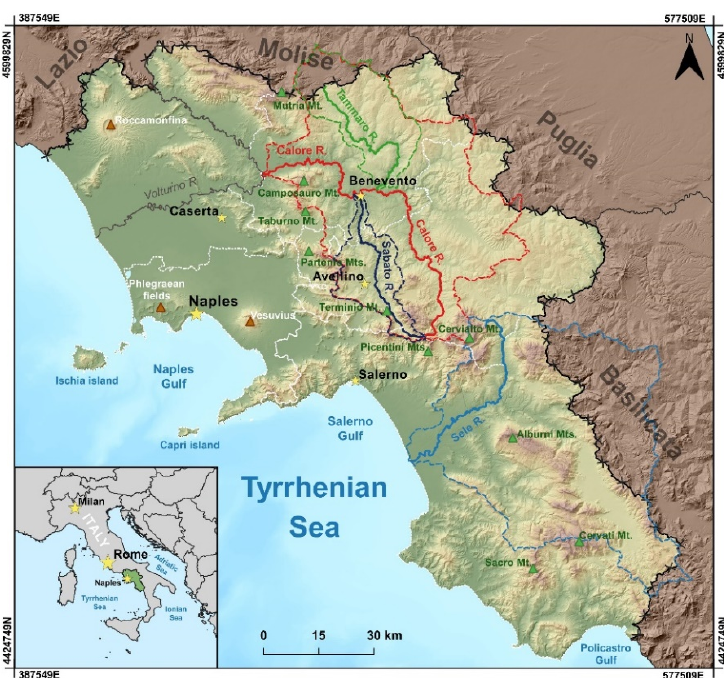
Figure 1. Location map of the Campania Region and of the investigated rivers (thick, continuous lines) and basins (dotted lines). Table 1. Main features of the investigated rivers.